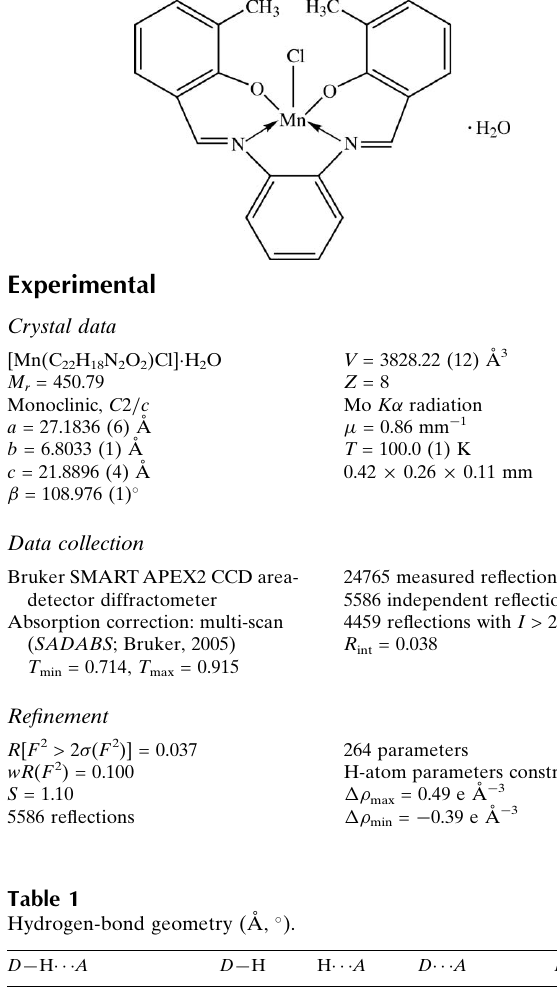
Hydrogen-bond geometry (A˚ , (cid:2)